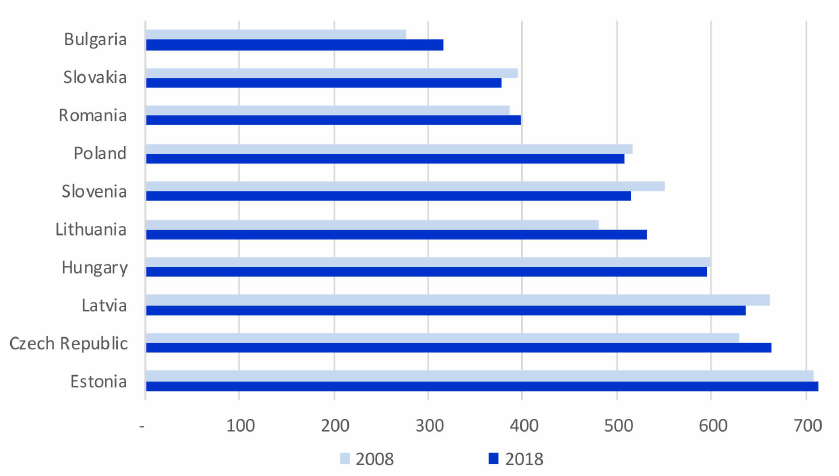
Figure 3. Changes in energy consumption in households per capita in the CEE countries in